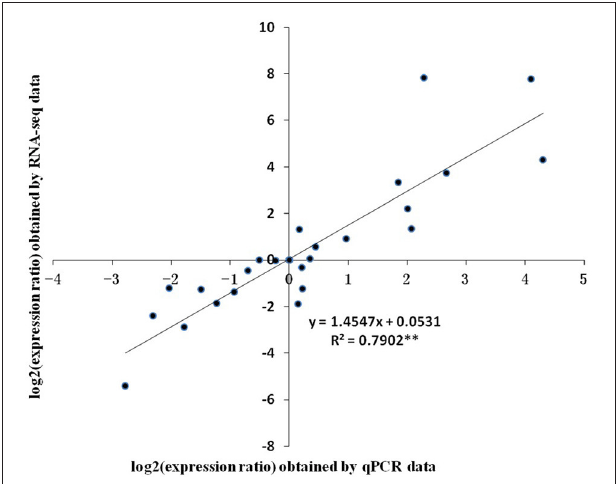
FIGURE 9 | Correlation of relative gene expression levels obtained from RNA-Seq and from qPCR. The expression ratio was the ratio of gene expression level at one stage against the one at previous stage. Vertical bars represent standard errors of means ( n = 3).